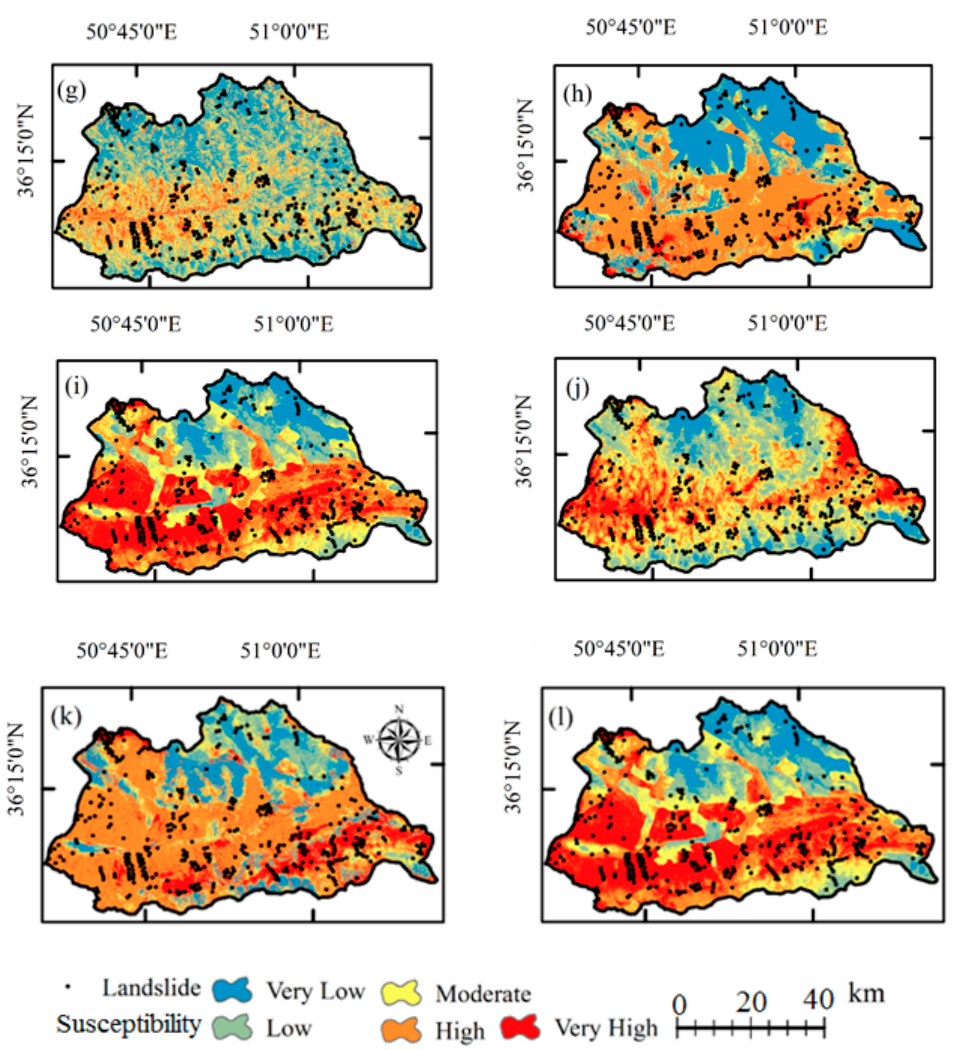
Figure 5. Landslide susceptibility mapping produced by using K-fold-1 ( a ) CDT, ( b ) CDT-ADTree, and ( c ) ADTree; using K-fold-2 ( d ) CDT, ( e ) CDT-ADTree, and ( f ) ADTree; using K-fold-3 ( g ) CDT, ( h ) CDT-ADTree, and ( i ) ADTree; and using K-fold-4 ( j ) CDT, ( k ) CDT-ADTree, and ( l ) ADTree.